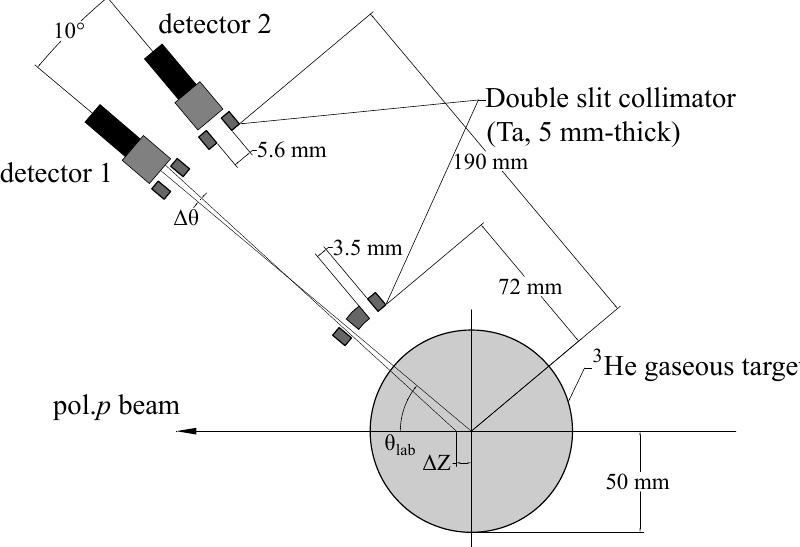
Figure 1: Schematic view of the experimental